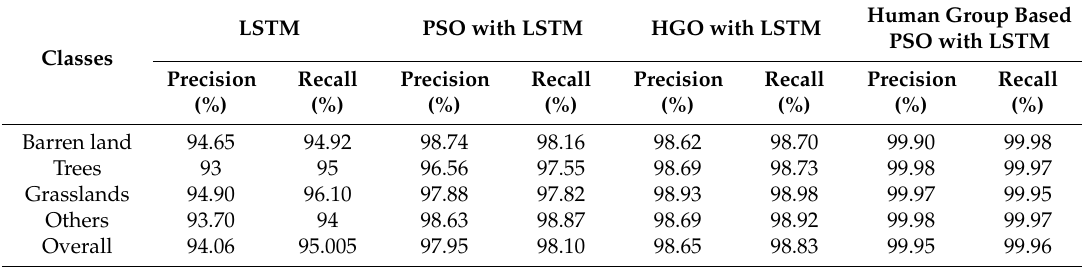
Table 6. Performance investigation of the proposed model with different optimization techniques on Sat 4 dataset by means of recall and precision.